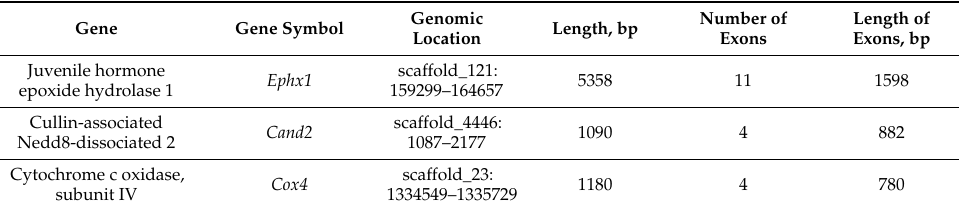
Table 1. Target genes and their parameters.